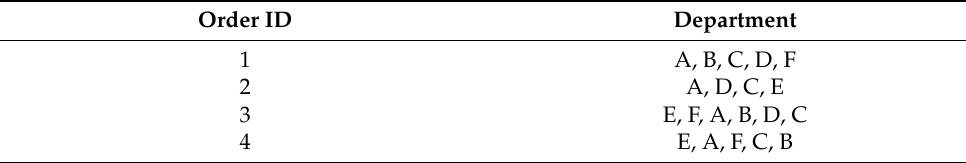
Table 5. Department transaction